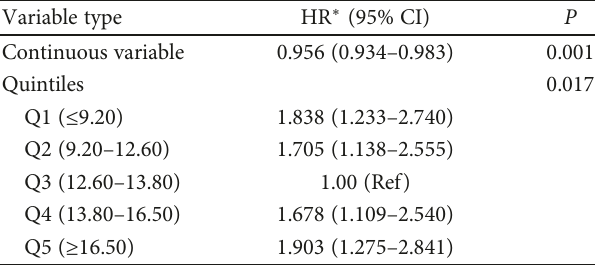
Table 3: HRs and 95% CI of DR incidence according to baseline TBiL levels ( μ mol/L).